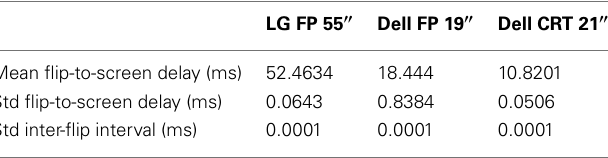
Table 2 | Measured time delays between video update signal and actually screen